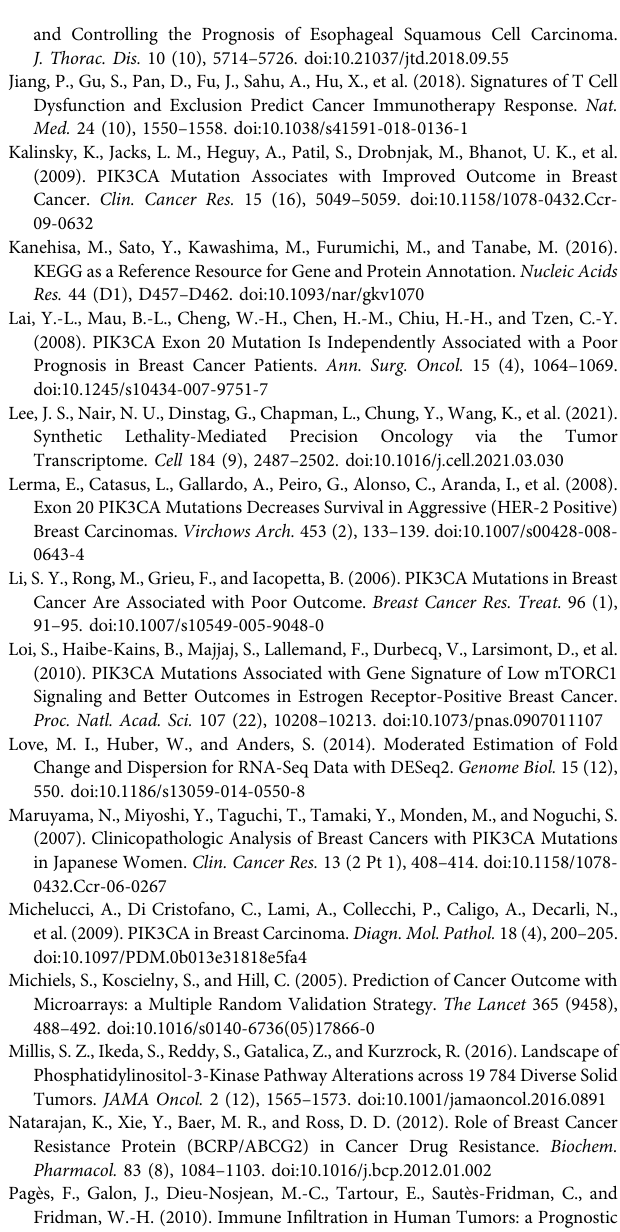
Supplementary Figure S2 | MultivariateCoxregressionanalysisofprognosticfactors for overall survival in TCGA patients. Age, tumor stage, proliferation score, IFNg score, cytolytic activity as well as our classi fi er were taken into consideration in this analysis.